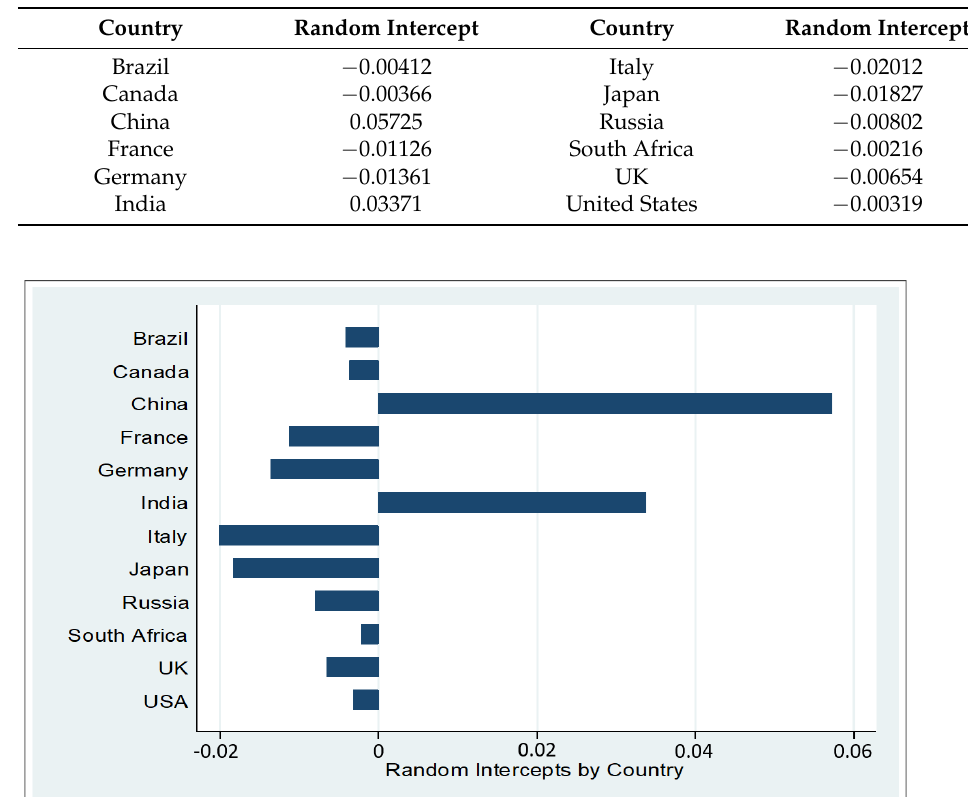
Table 7. Expected Values of Intercepts of Random Effects by Country Estimated by the Linear Trend Model of Explanatory Variable Level 1 — YEAR.